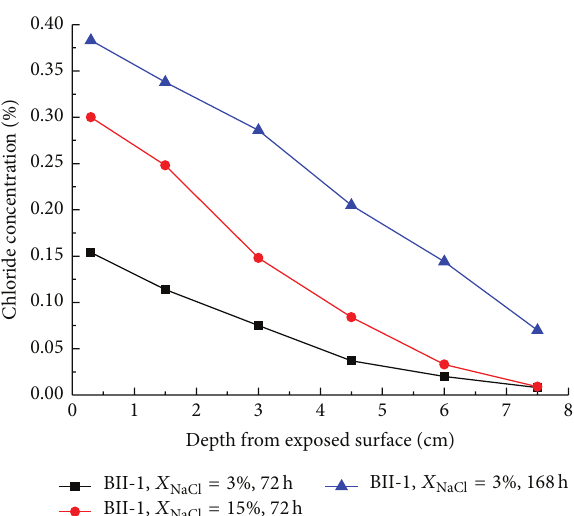
Figure 7: Chloride concentration profile under different hydraulic